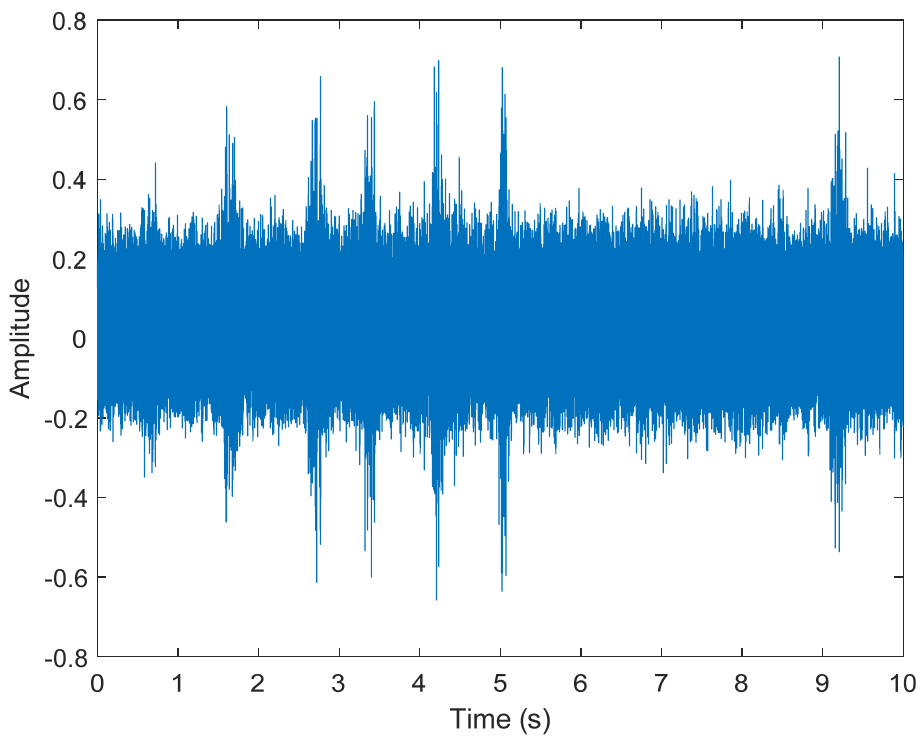
Figure 27. Original source of motor bearing failure.